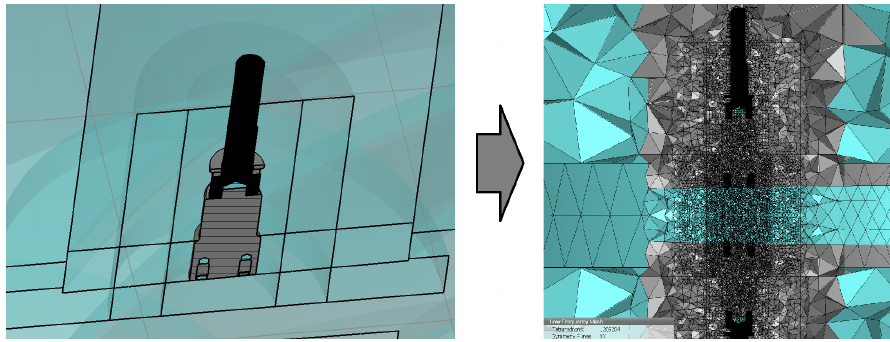
Figure 1. The model partitioning resulted into elements concentrated into screw area.